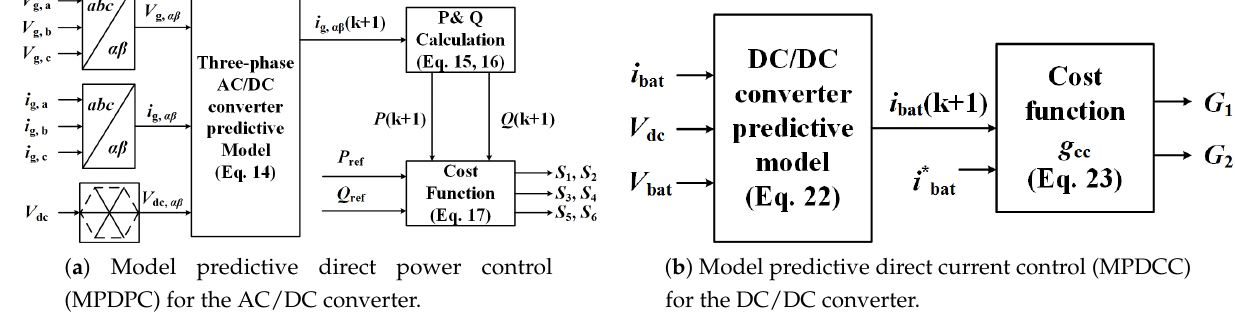
Figure 6. Proposed control